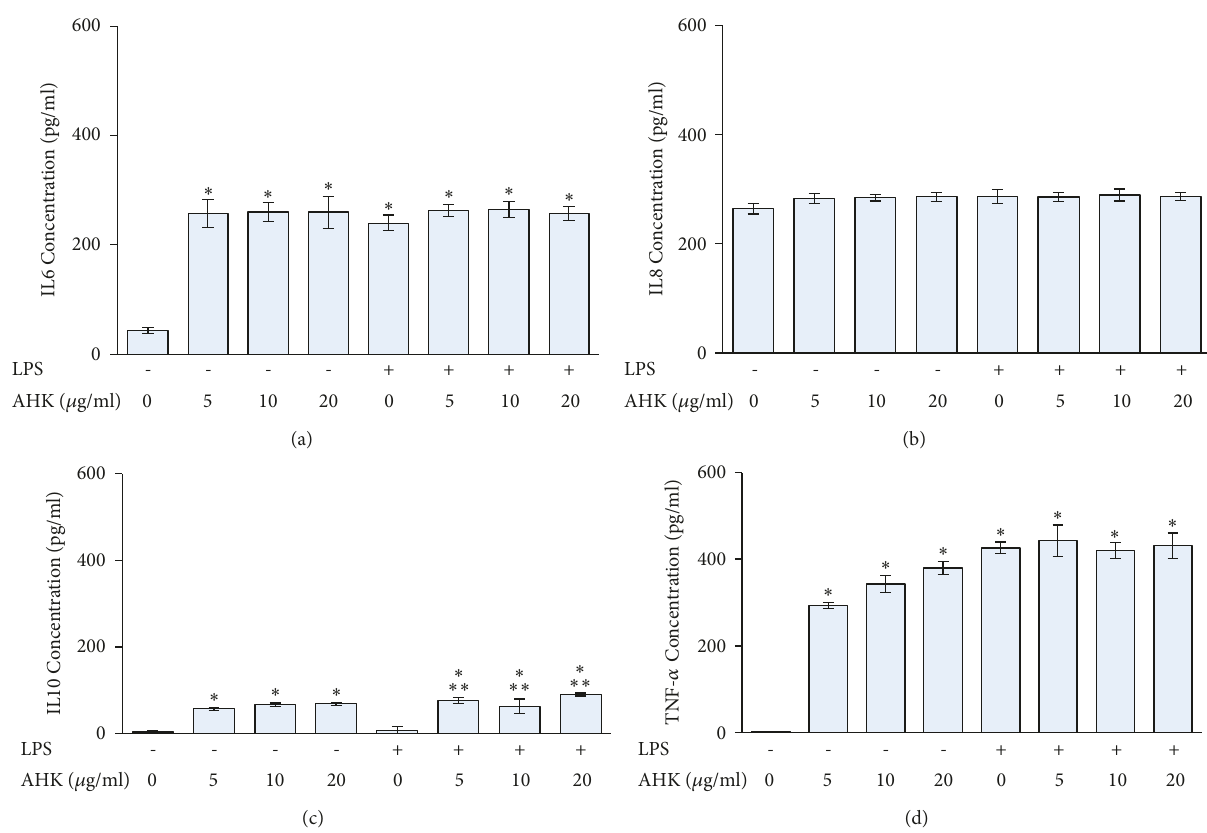
Figure 3: The effect of AHK on IL6 (a), IL8 (b), IL10 (c), and TNF- 𝛼 (d) production in PBMCs and LPS-treated PBMCs. PBMCs were separated using Ficoll-Paque density centrifugation, seeded in 12-well plates, and treated with 10 𝜇 g/ml LPS and AHK at the indicated concentrations for 24 h. The levels of IL6, IL8, IL10, and TNF- 𝛼 secretion were determined using ELISA with specific antibodies to each cytokine. ∗ p < 0.05 compared to control group; ∗∗ p < 0.05 compared to LPS-treated group